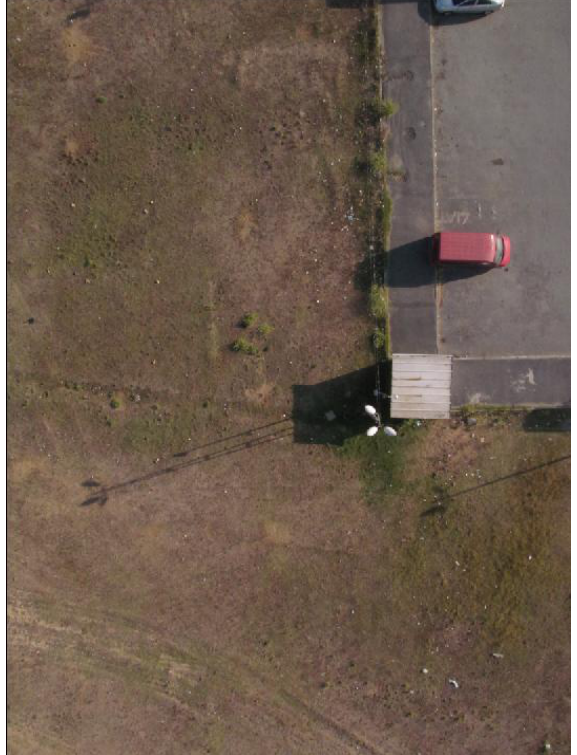
Figure 4. The recorded image of test area acquired with Canon SX 150 compact camera mounted on designed UAV